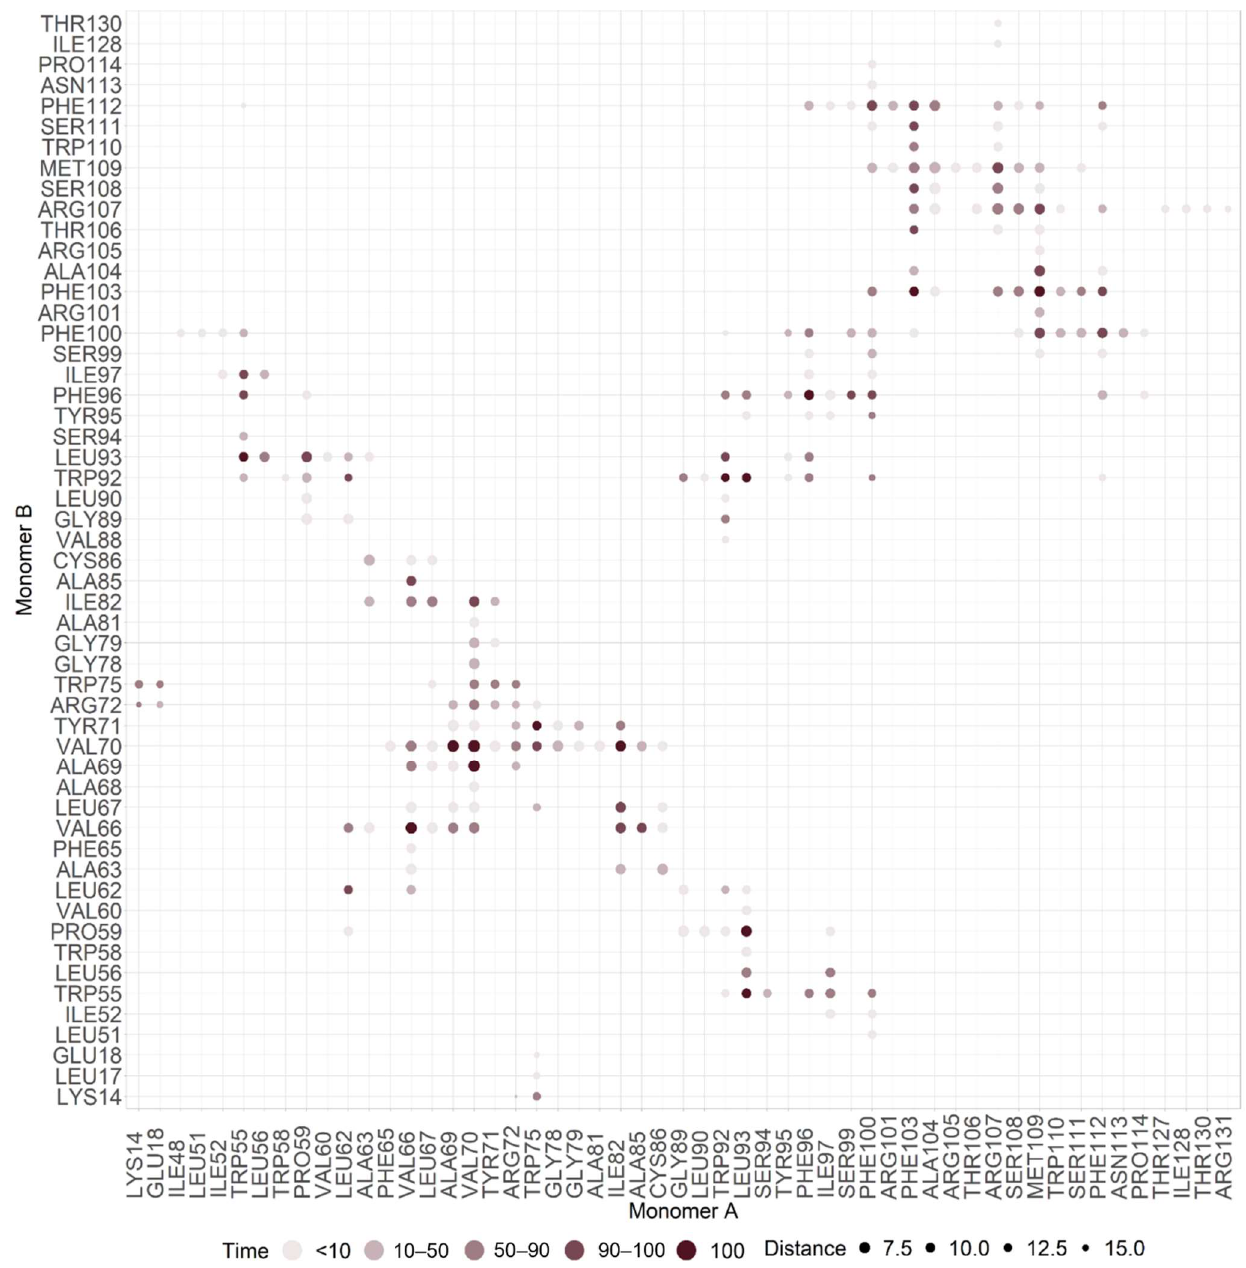
Figure 4. Contact map of M protein homodimer interface. Interactions between monomer A and monomer B residues W59-L93, V66-V66, A69- V70, V70-A69, V70-V70, W75-Y71, I82-V70, W92-W92, L93-P59, F96-F96, F103-F103, and M109-F103 were prevalent interactions throughout 100% of MDs simulation time, with side chain distances lower than 5 Å (Table 1, Figures 4 and 5). These regions also showed